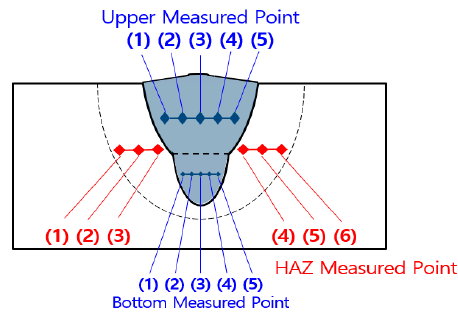
Figure 4. Schematic diagram of the hardness test. Table 6. Results of hardness according to welding process and